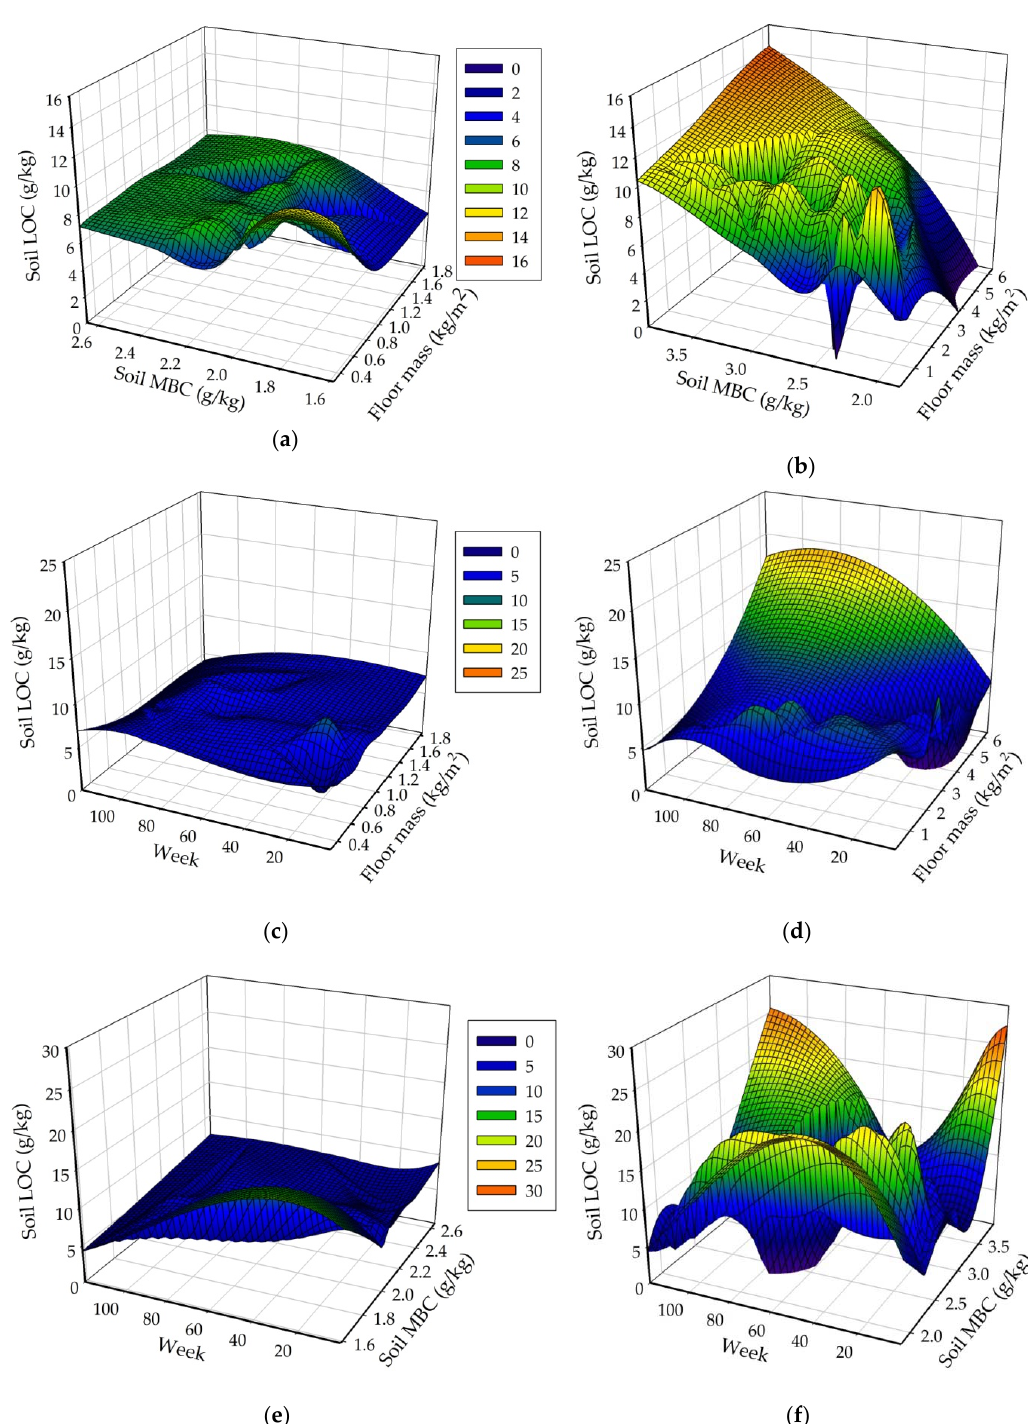
Figure 3. Soil LOC in correspondence to floor mass and soil MBC in ( a ) the control and ( b ) CTDD plots, floor mass, and weeks following CTDD treatment in ( c ) the control and ( d ) CTDD plots, and soil MBC and weeks following CTDD treatment in ( e ) the control and ( f ) CTDD plots in the Luquillo Experimental Forest, Puerto Rico.